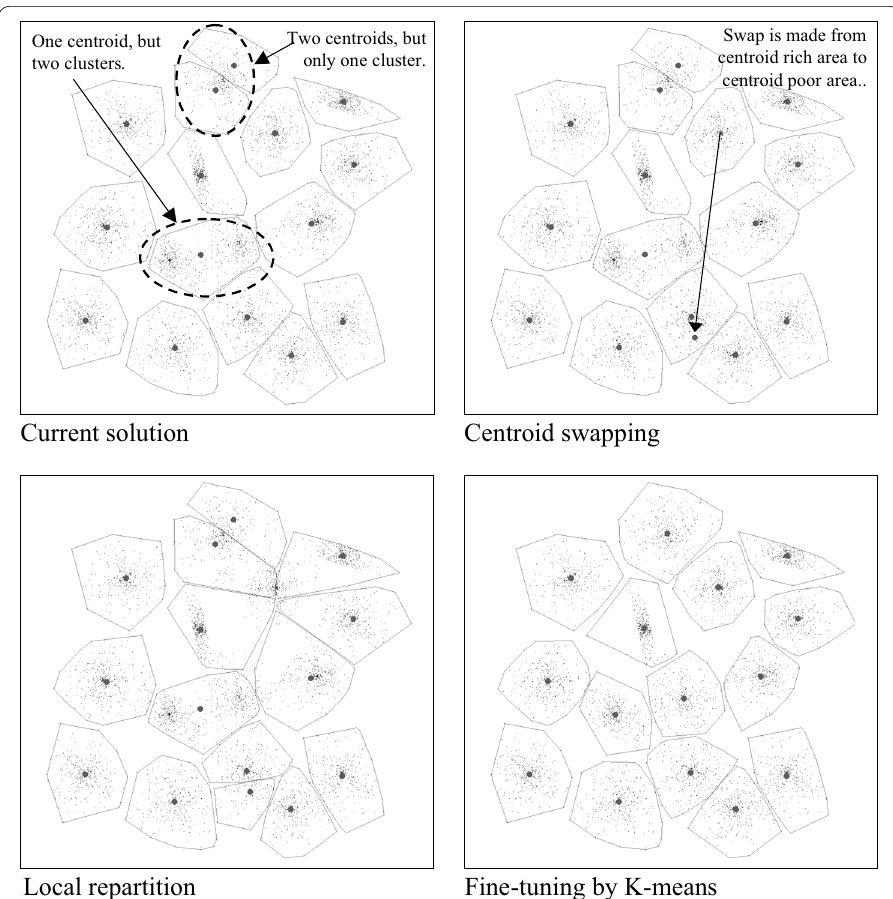
Fig. 2 Demonstration of the prototype swap for a sample initial solution for N k 15 clusters (data set S 2 =